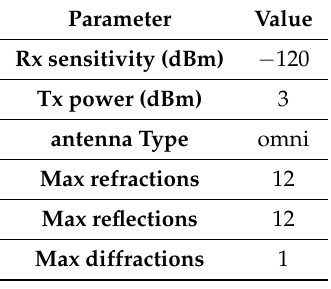
Table 1. Wireless Sensor Network (WSN) and radio propagation